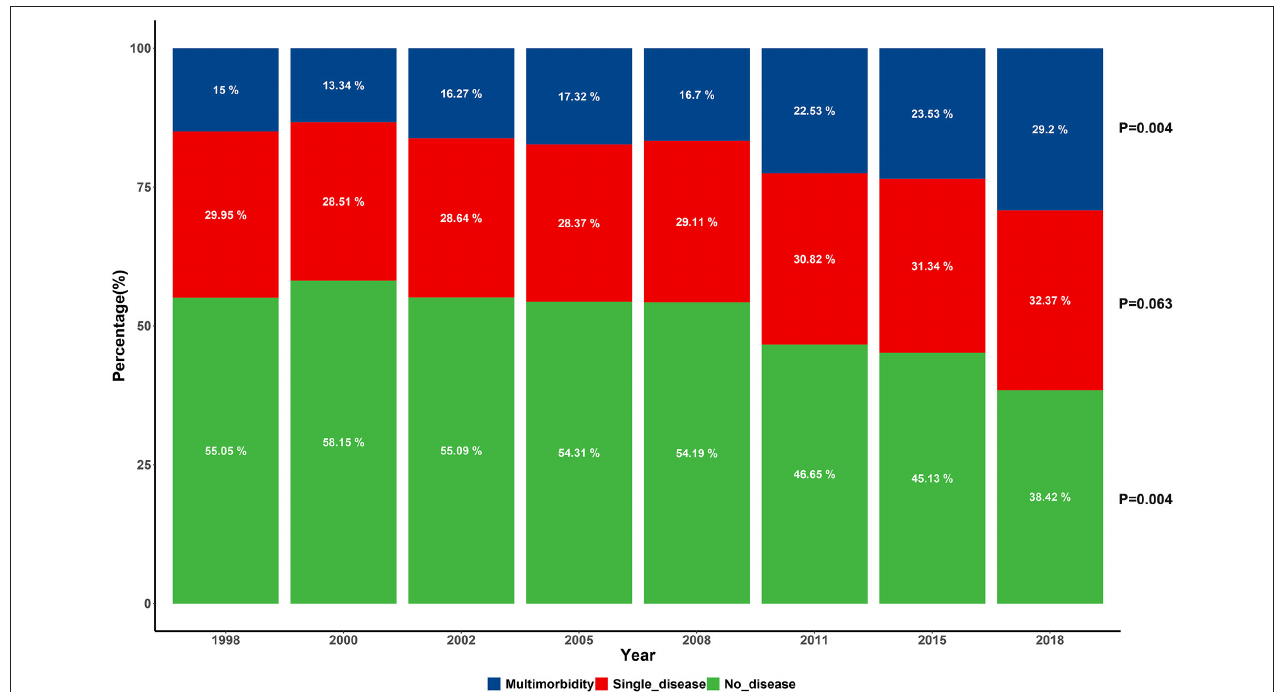
FIGURE 1 | Percentage of the elderly suffering from the various number of chronic conditions across the survey of eight waves.